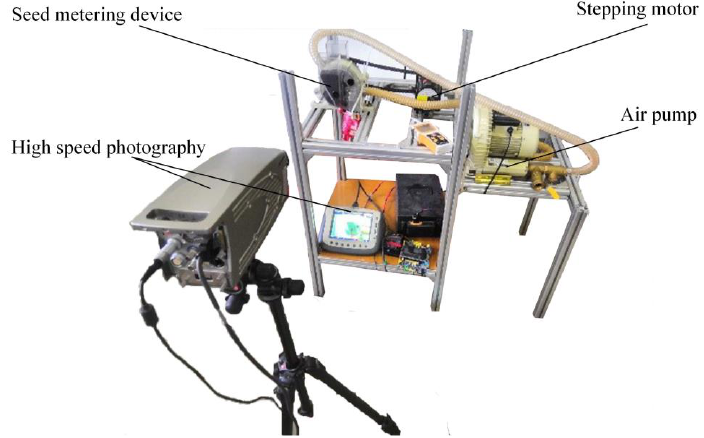
Figure 10. Seed filling performance test stand.